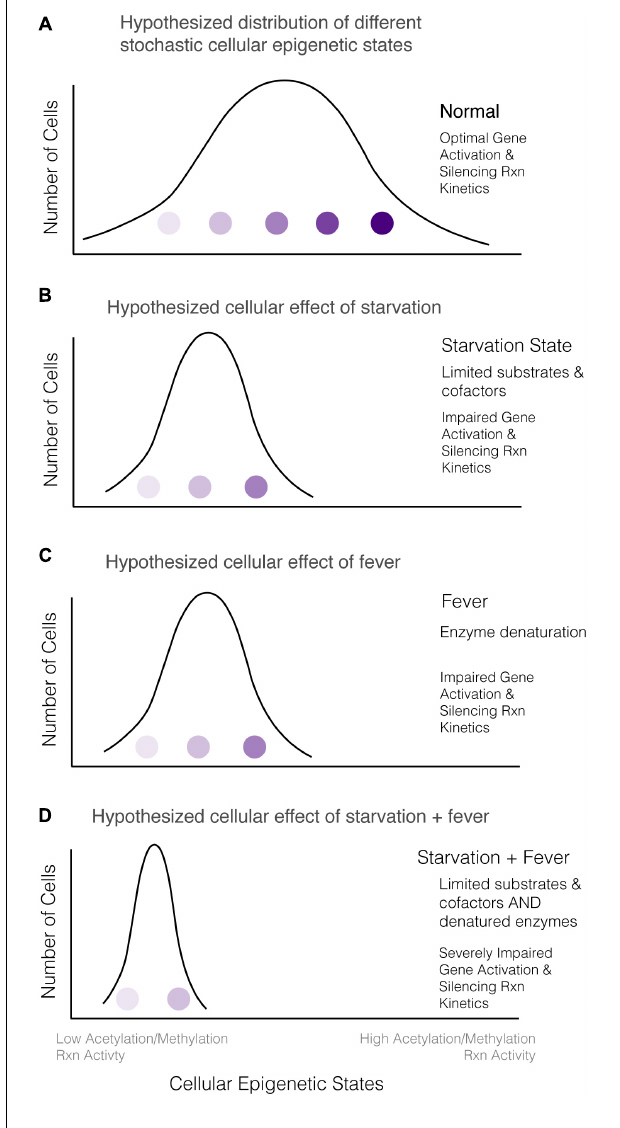
FIGURE 7 | Schematic depiction of the hypothesized effects of combining starvation/FMD and fever/hyperthermia on tumor cell epigenetic diversity. (A) At baseline, enzyme kinetics are optimal and all possible stochastic epigenetic cellular states can be occupied in a population of cells. (B) Starvation limits essential substrates and cofactors for chromatin modifying enzymes, constraining epigenetic dynamics the number of states that a cell can occupy. (C) Fever/hyperthermia denatures chromatin modifying enzymes, inhibiting their activity and constraining the number of different epigenetic states that a cell can potentially occupy. (D) The combination of starvation and fever/hyperthermia creates a state that severely constrains cancer cell potential for epigenetic